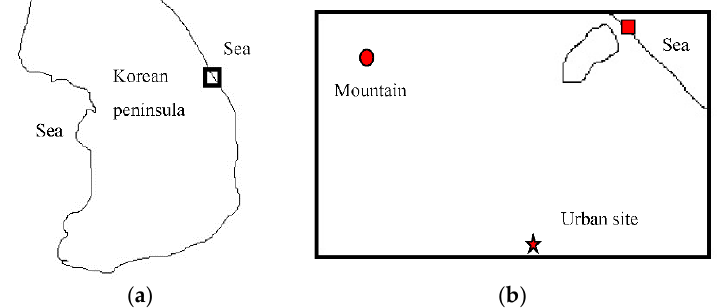
Figure 1. Sampling locations on the eastern Korean peninsula: mountain site (circle), seashore site (square), and urban site (star). ( a ) Korean peninsula, ( b ) Sampling locations.